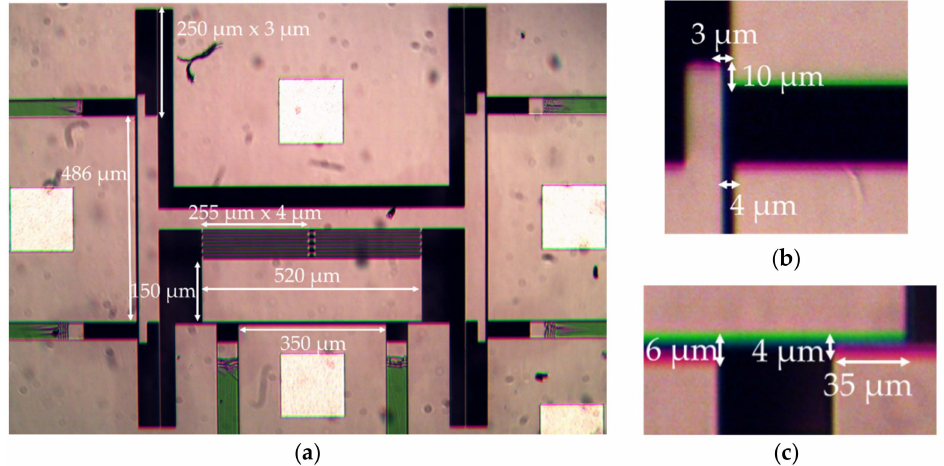
Figure 7. Micrographs of the final translational MEMS platform with critical design dimensions for: ( a ) platform, springs and actuators; ( b ) lateral switching actuator and stopper; ( c ) longitudinal gap closing actuator and